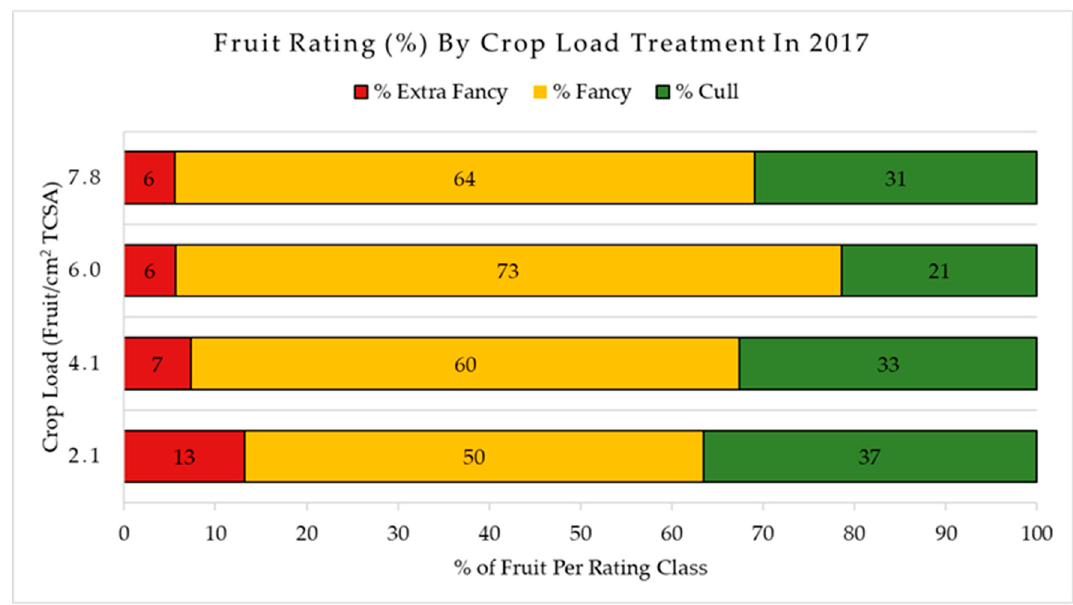
Figure 4. Fruit class rankings (extra fancy, fancy, and cull) for “WA38” fruit harvested in the fall of 2017 in Washington State, Wenatchee area, across each crop load (2.1, 4.1, 6.0, 7.8 fruits/cm 2 ) category. All fruits per trial tree were rated immediately after harvest on 9 October 2017.